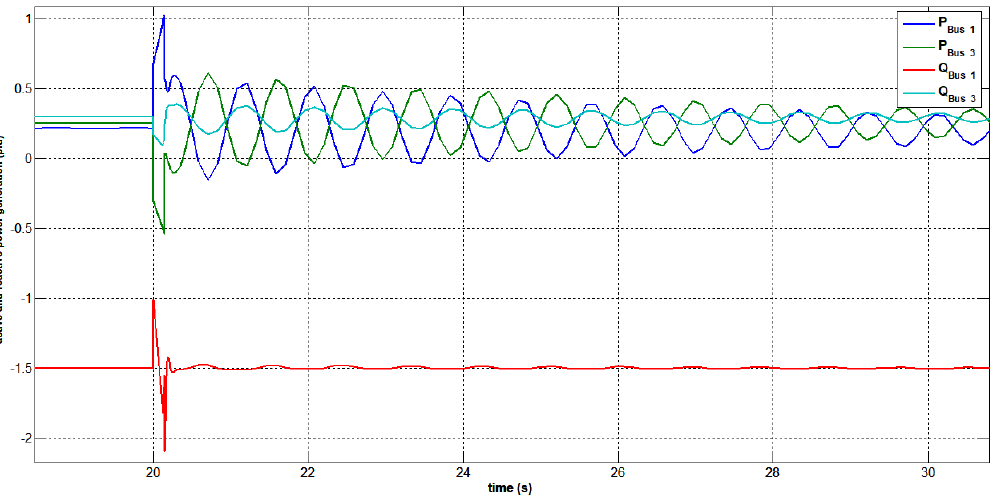
Figure 50. Voltage variation at bus 15 under a three ‐ phase short circuit at bus 3 with STATCOM.